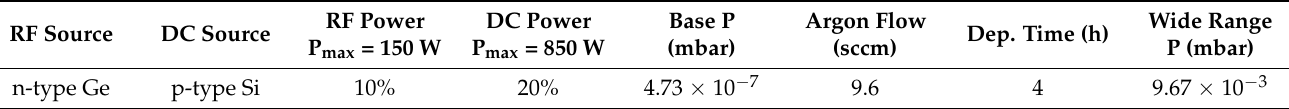
Figure 1. Schematic diagram of co-sputtering by physical vapor deposition (nano-PVD). Table 1. Parameters for deposition of SiGe thin film.